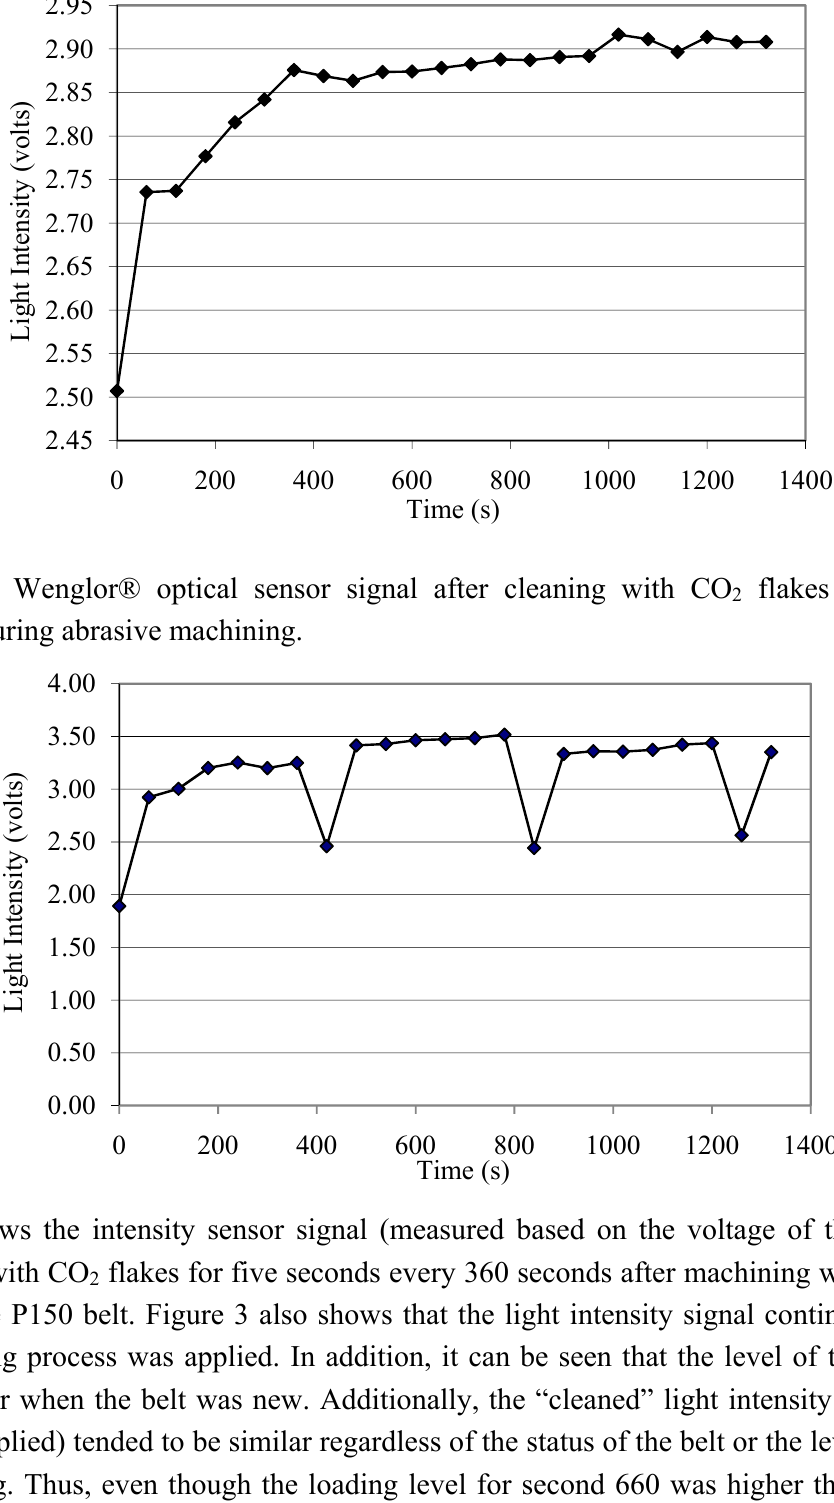
Figure 2. Wenglor® optical sensor signal as a function of machining time when abrasive machining is performed.